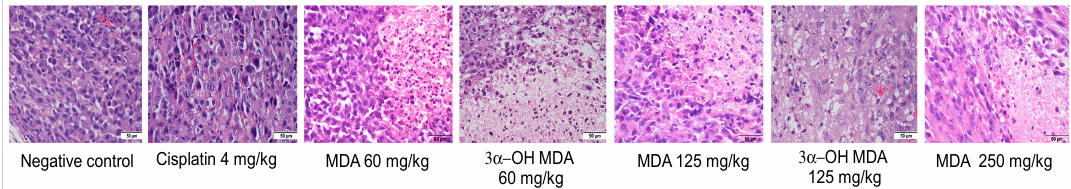
Figure 3. Representative photomicrographs of hematoxylin-eosin staining of tumor tissues.